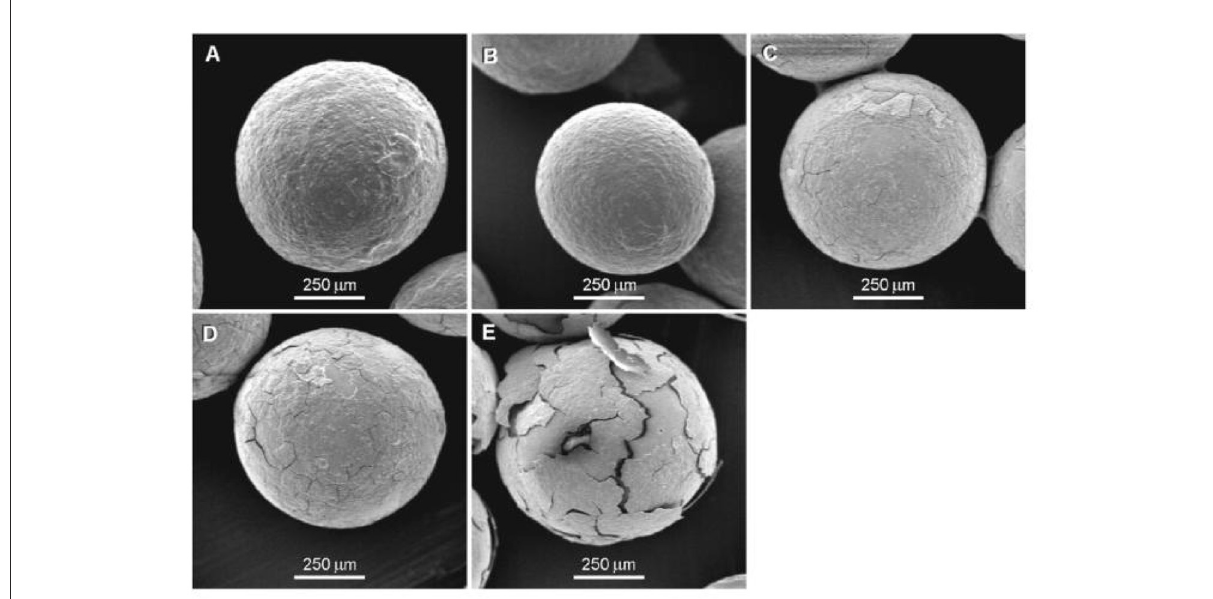
FIGURE3 SEM images of 1.4 mgycm HACS coatings with 20% RS on glass beads. (A) Without treatment, (B) after continuous dissolution test of 2h incubation in pH = 1.6 following 3h incubation in pH = 7.0, 37 ◦ C, 75 rpm (C) after 0.5h enzymatic digestion test with 35 U/ml pancreatic